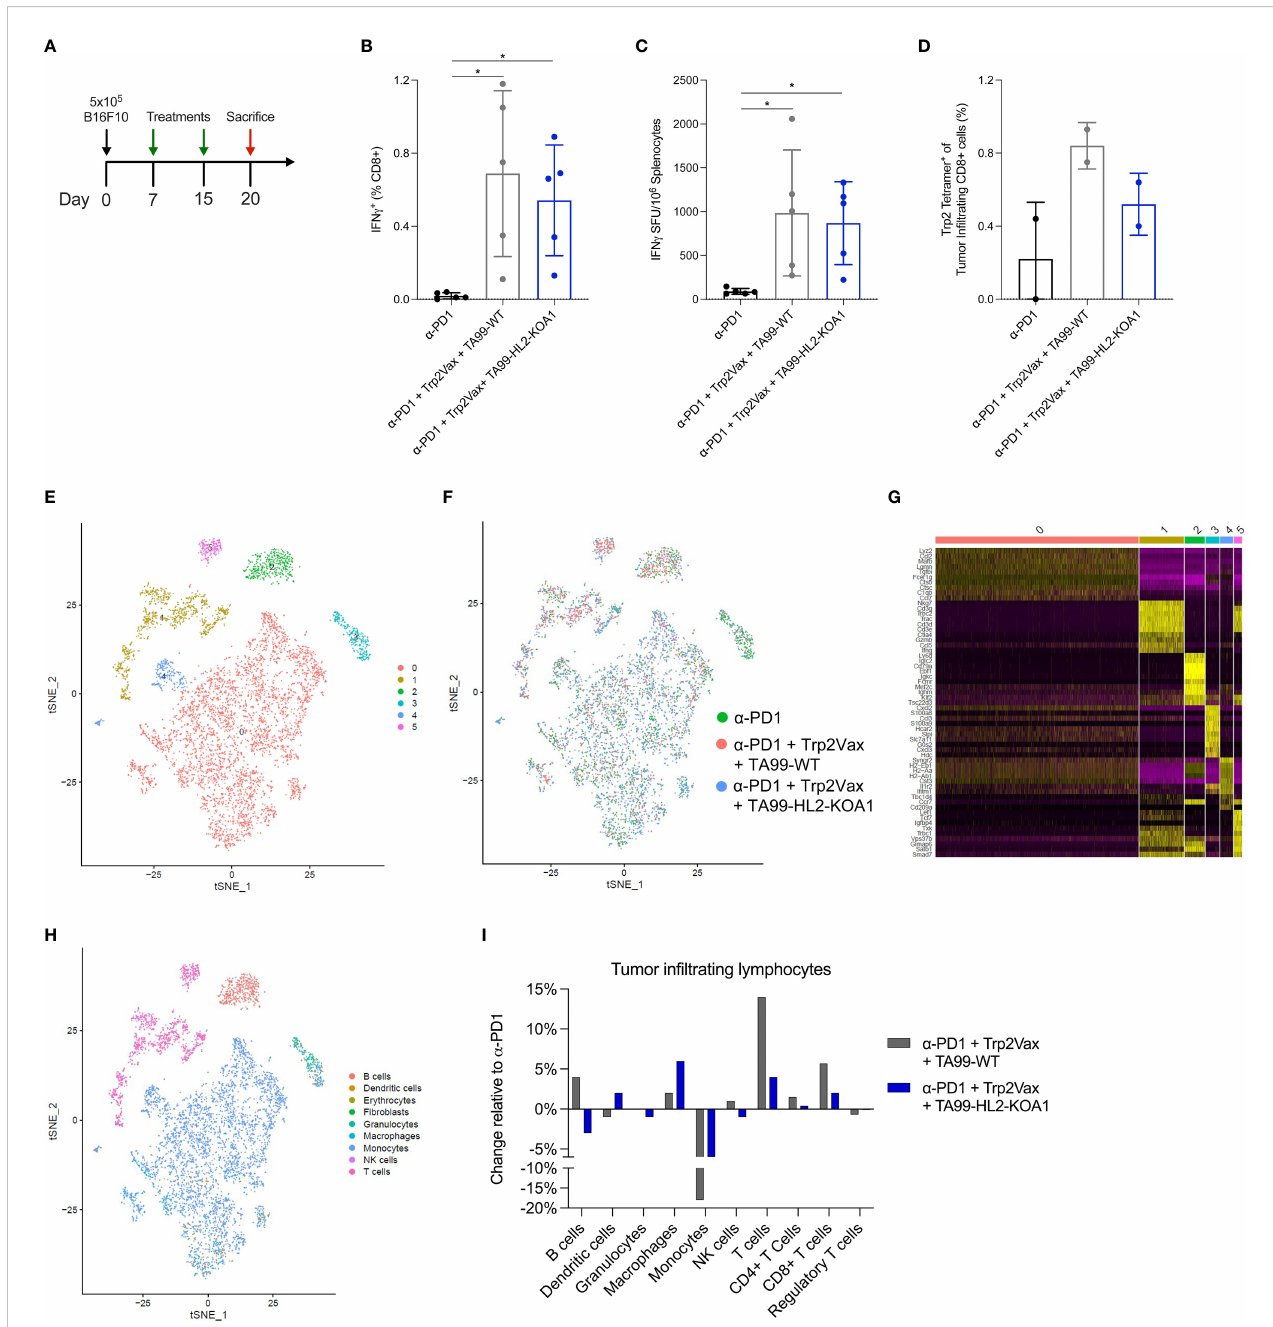
FIGURE 3 Single cell RNA sequencing revealed increased intratumoral in fi ltration of T cells following DLnano-vaccines and TA99-based immunotherapy treatments. (A) Tumor inoculation, treatment, and euthanasia scheme of the study. Mice received 5 x 10 5 B16F10 cells subcutaneously on D0, and 2 treatments of either anti-PD1 only (200µg), anti-PD1 (200µg) + Trp2Vax (10µg of DLnano_LS_Trp2 188 ) + WT TA99 (50µg) or anti-PD1 (200µg) + Trp2Vax + TA99-HL2-KOA1 (50µg) on D8 and 15, and were euthanized on D20 for spleen and tumor collection. (B, C) Trp2Vax induced Trp2-speci fi c splenic IFN g + CD8+ T-cell responses as determined by ICS (B) and ELISpot (C) . (D) Frequency of Trp2-tetramer speci fi c CD8+ T cells intratumorally in mice receiving each speci fi ed treatment. (E) TSNE plot demonstrating major clusters (0-5) of TILs isolated from three groups of mice after sample integration. (F) TSNE plot demonstrating distribution of TILs from each specimen amongst the main identi fi ed clusters from (E) . (G) Identi fi cation of top 10 most highly expressed genes in each cluster from the TSNE plot in (E) . (H) Assignment of each cluster with its respective cell type according to its gene signatures using SingleR and referencing mouseRNAseq database. (I) Comparison of the frequencies of each cell type amongst TILs from the three specimens. N=5 mice/group for (A – C) ; Two groups mice were pooled for TIL analysis in (D) ; N=5 mice/group were pooled for transcriptomic analyses in (E – I) . each dot represents a sampling point (individual animal, or individual pool of animal receiving same treatment). Error bar represents standard deviation. Two-tailed Mann-Whitney Rank test used to compare groups; p-values were adjusted for multiple comparison for (B – D) .